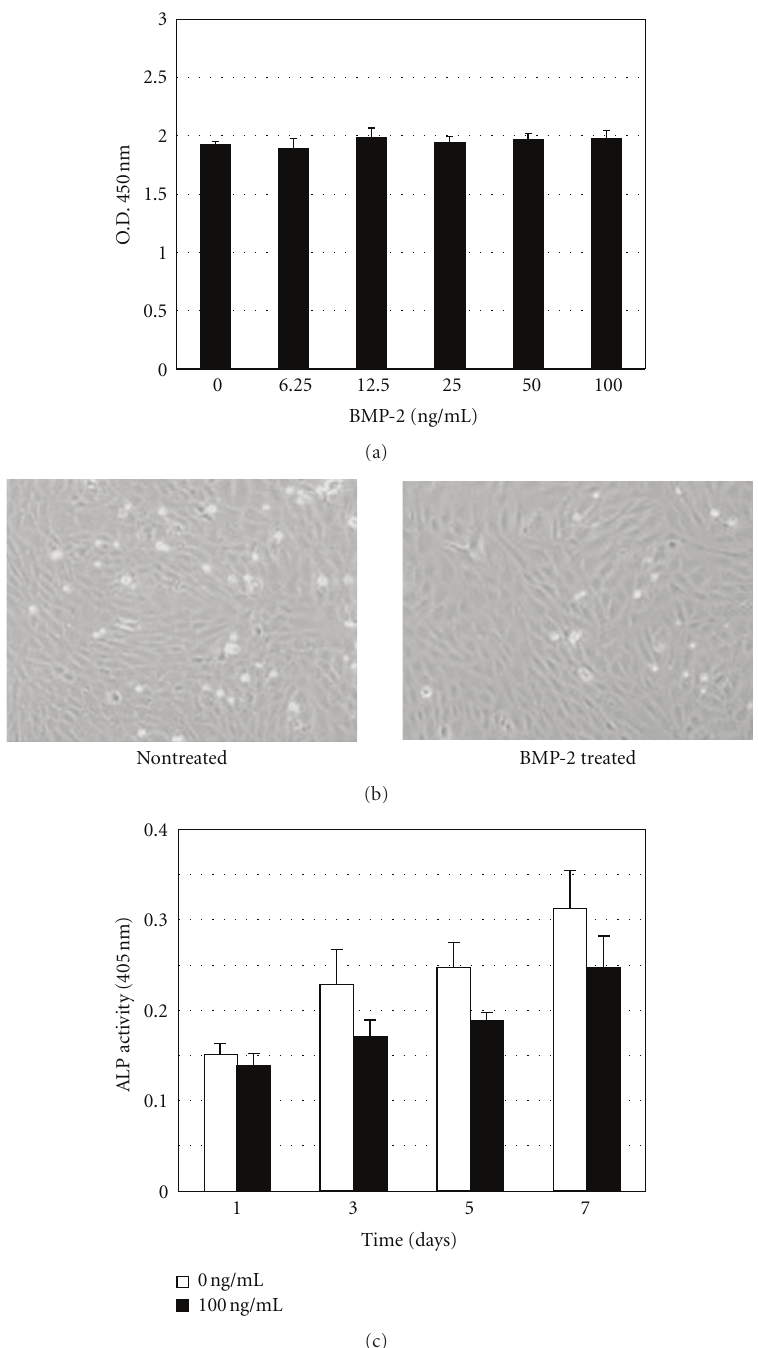
Figure 1: (a) Viability of KN-3 cells after exposure to BMP-2. Data are expressed as the mean ± standard deviation of triplicate cultures. Each experiment was performed 3 times, with similar results obtained in each. (b) Phase-contrast microphotographs of KN-3 cells treated with BMP-2 (100 ng/mL) for 72 hours. (c) Alkaline phosphatase activity of KN-3 cells treated with BMP-2 (100ng/mL). BMP-2 was replaced with fresh medium every 3